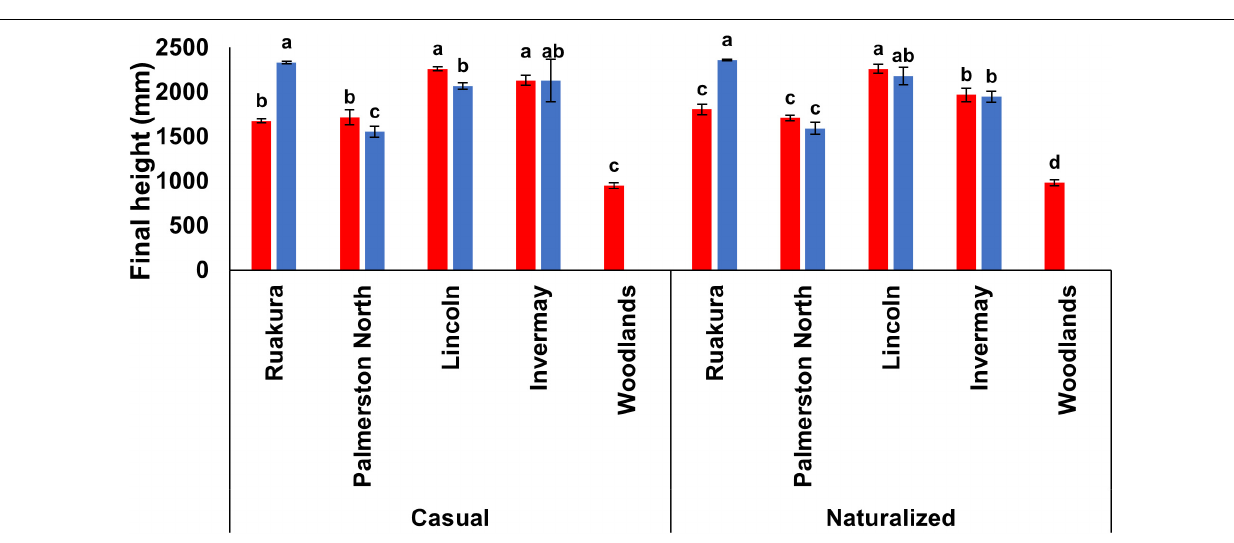
FIGURE 5 | Final plant height for the casual and naturalized populations of A. theophrasti in five different regions of New Zealand in the first (red bars) and second (blue bars) experiments. In the second experiment, plants in Woodlands died after emergence. For each population, vertical bars of the same colour with different letters are significantly different at 5% probability. The error bars represent ± standard error of the